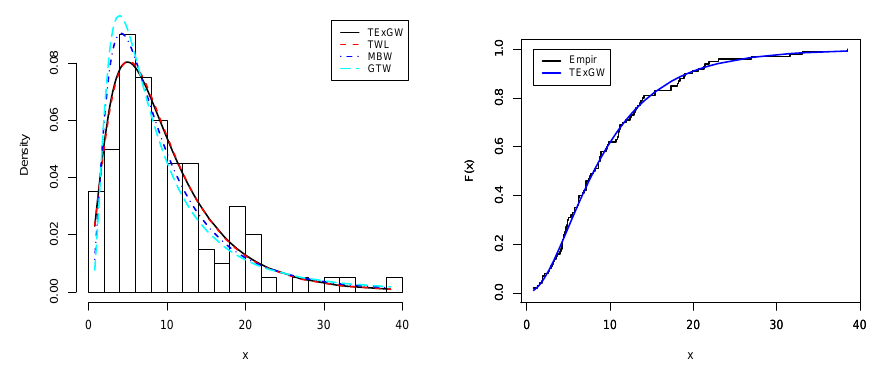
Fig. 5. The fitted pdfs (left panel) and the TExGW fitted cdf (right panel) for data set